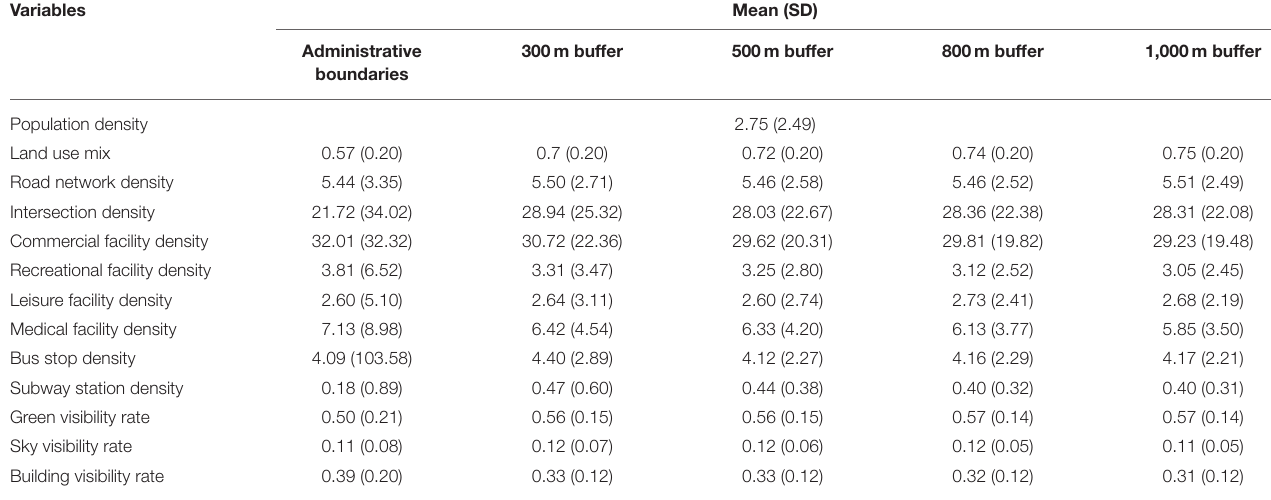
TABLE 3 | Descriptive statistics for neighborhood characteristics.